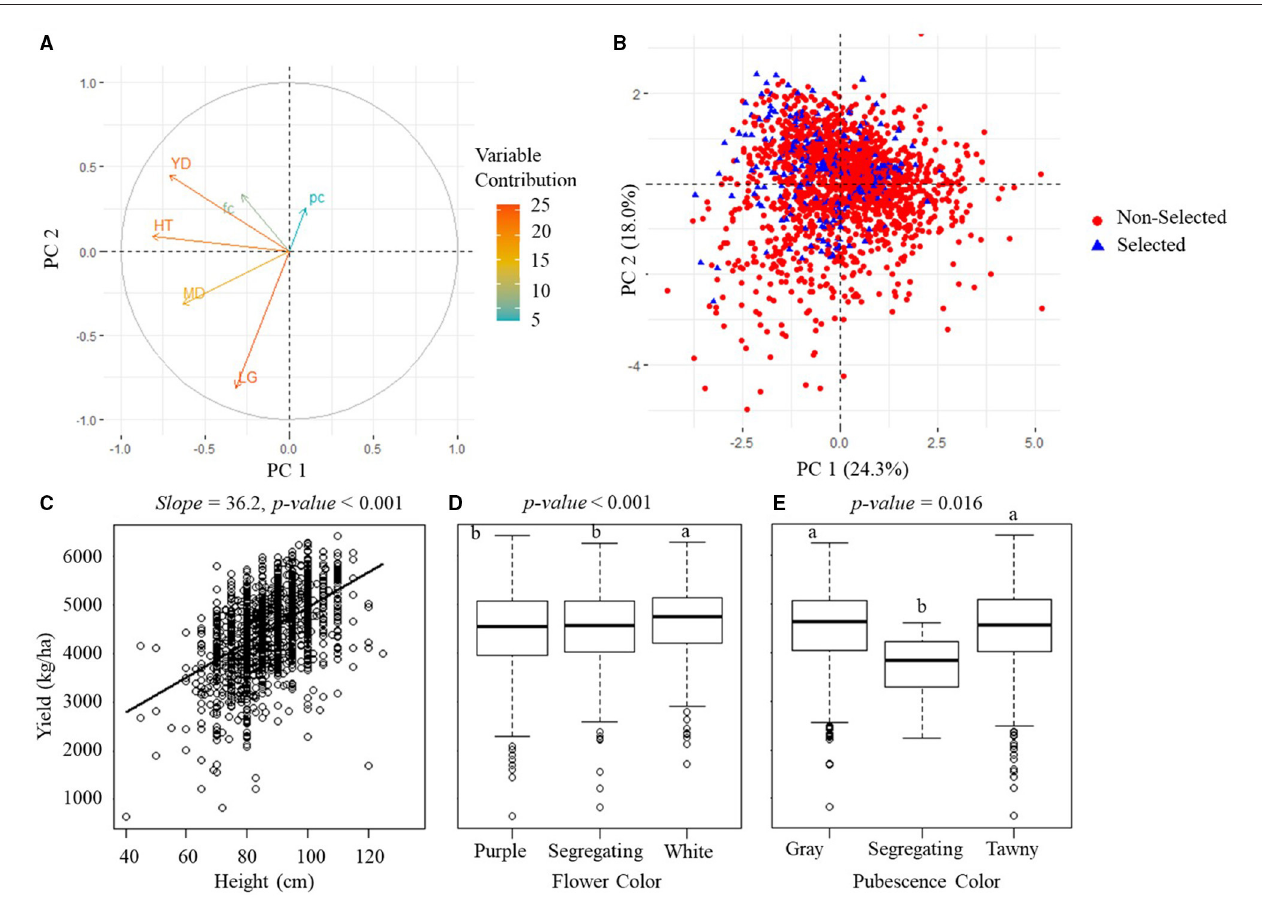
FIGURE 6 | Manually measured agronomic traits in PYT. (A) The visualization plots of the variables’ contributions and directions in the plane of the first two PCs. YD, yield; HT, plant height; MD, maturity date; LG, lodging; fc, flower color; pc, pubescence color. (B) The projection of sample variables on the first two PCs. (C) The scatterplot of yield vs. plant height. (D,E) The boxplots of the yield of three groups of flower color and three groups of pubescence color. The p-value above (C–E) indicates the significance level of